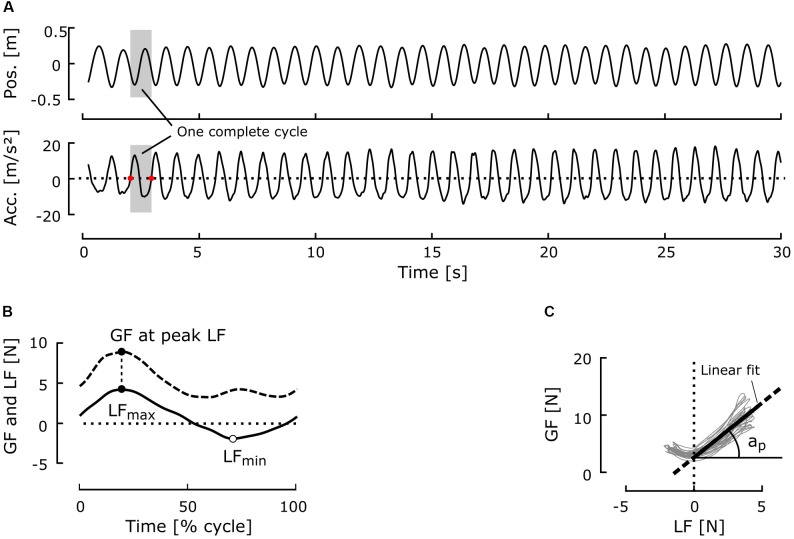
Typical time series and variables of interest. (A) Typical position and acceleration signals in one block. The gray area represents one complete cycle. The zeros of the acceleration signal during the downward movement of the arm (red dots) delimit the cycles. (B) Typical GF and LF traces during one cycle of oscillation. (C) GF plotted against LF for one complete block (33 cycles here). The thick line represents the linear regression computed for positive LF values with the ordinary least-squares procedure. The R2 coefficient and slope ap were computed for each block from this linear regression.